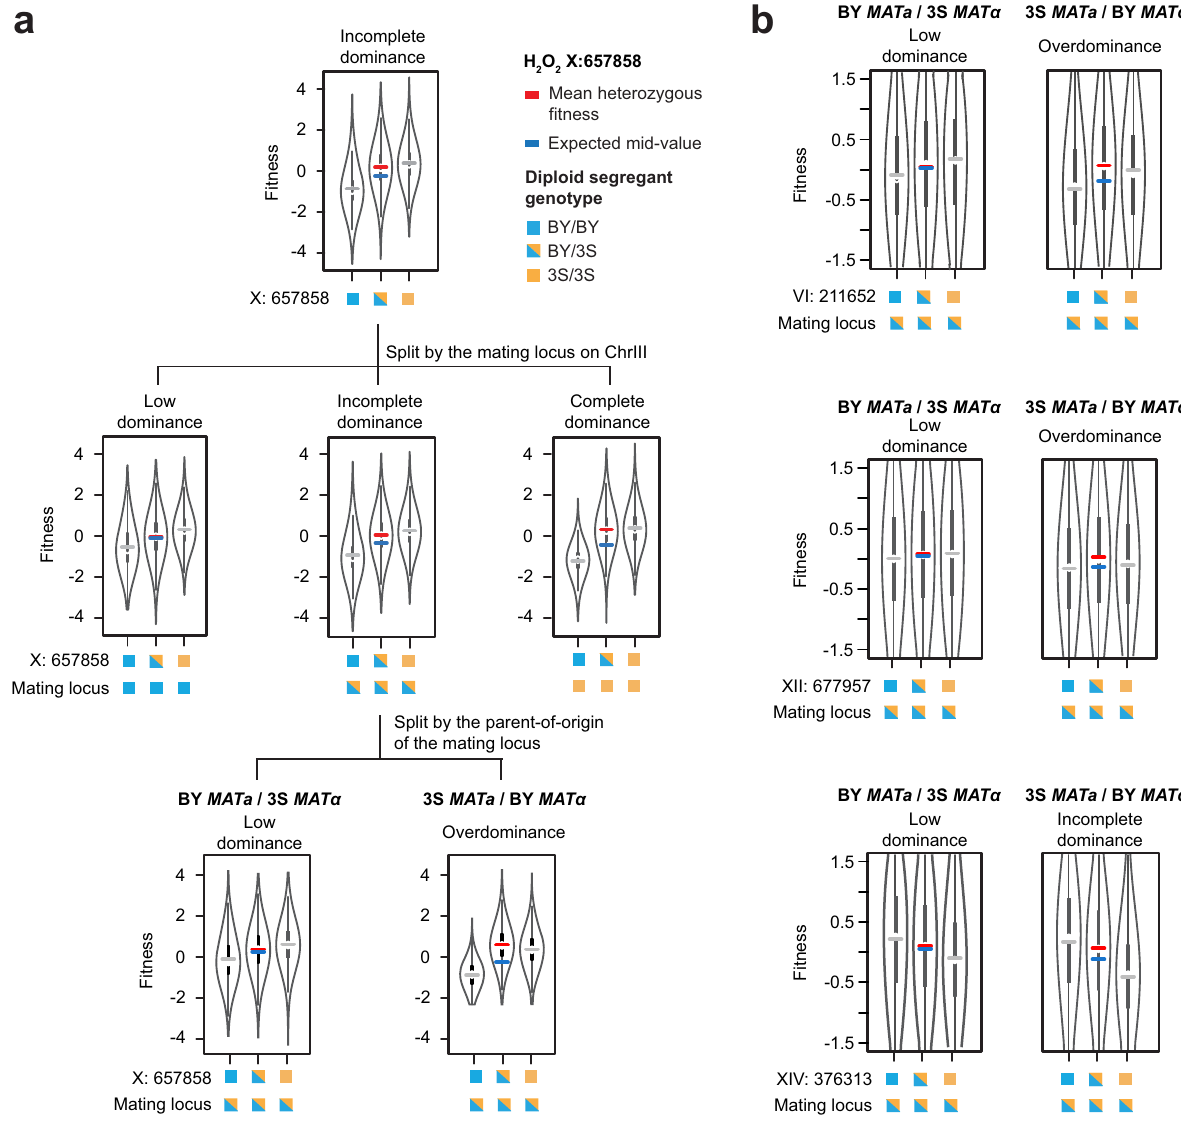
Fig. 5 Parent-of-origin of the mating locus in fl uences dominance at hubs. a Violin plots of the fi tness distribution of diploid strains split by the genotype at the Chromosome X locus (top), further split by the genotype at the mating locus on Chromosome III (middle), and the parent-of-origin at the mating locus (bottom). All genotype classes had n > 9000. Genotype state at each locus is denoted by colored boxes: BY/BY (blue), 3S/3S (orange), is BY/3S (half blue, half orange). Lines are the observed mean fi tness in the homozygous genotype classes (gray), the observed mean fi tness in heterozygous genotype classes (red), and the expected heterozygous fi tness if there was no dominance (blue). b Violin plots of the fi tness distribution of diploid strains split by the genotype state of a hub locus and the parent-of-origin of the mating locus: Chromosome VI hub (top), Chromosome XII hub (middle), Chromosome XIV hub (bottom). All genotype classes had n >